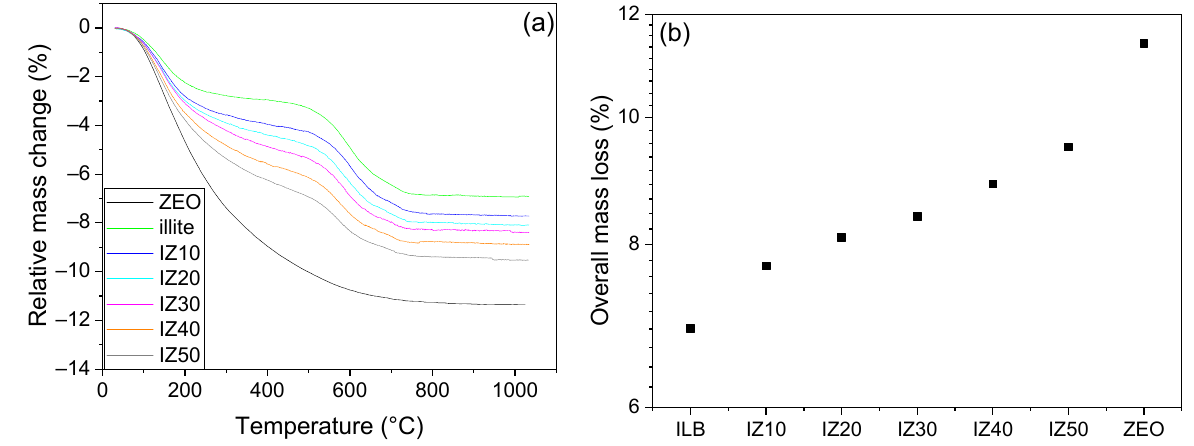
Figure 3. The mass change of the prepared samples and initial materials ( a ). Comparison of the total mass losses ( b ).